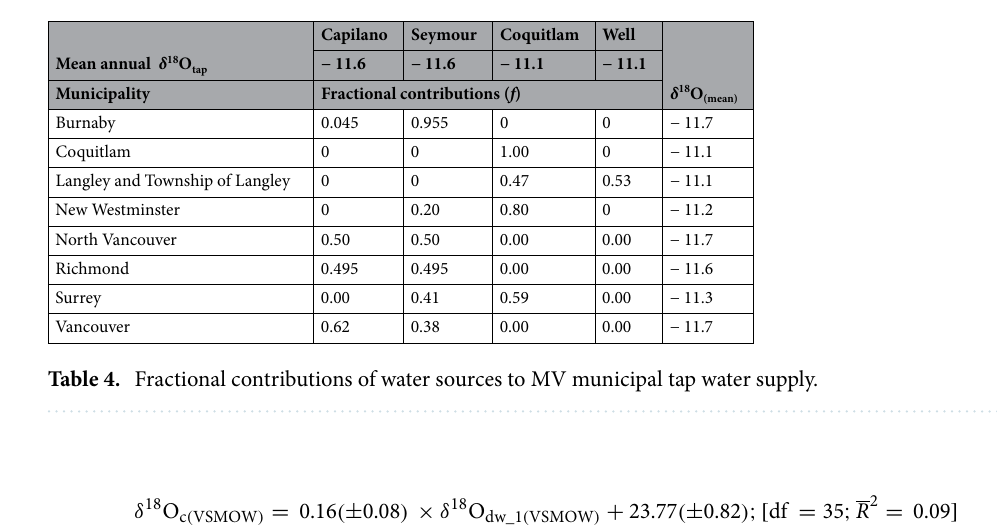
Figure 5. Monthly MV tap water δ 18 O data for samples taken between June 2017 to May 2018 at Coquitlam Water Treatment Plant (CWTP) and Seymour-Capilano Filtration Plant (SCFP). Mean annual MV tap water δ 18 O values were – 11.1‰ and – 11.7‰ at CWTP and SCFP, respectively.